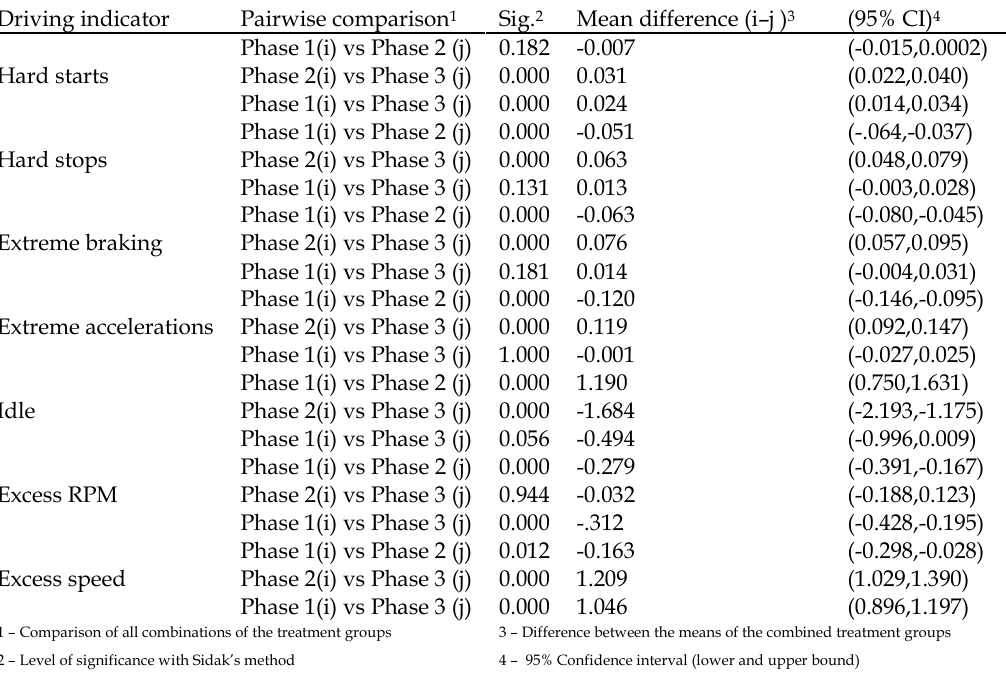
Table 5. Pairwise comparisons for the driving indicators